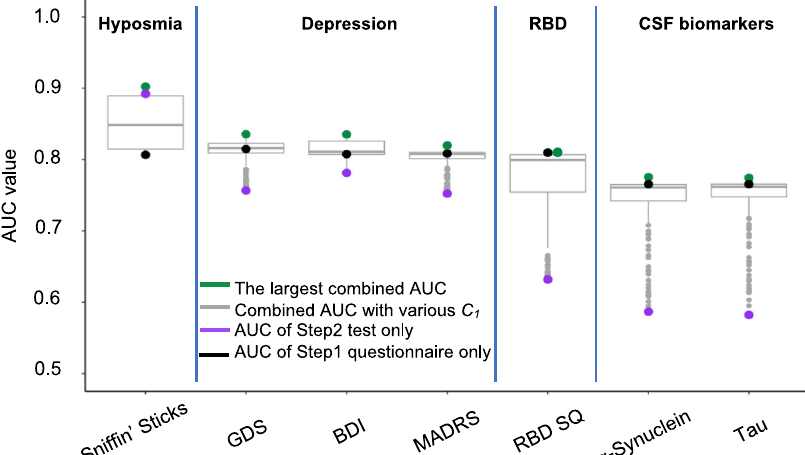
Fig. 7 Comparison of outcomes for a screening-adapted version of the PREDIGT Score (Model 2) to separate Parkinson ’ s patients from healthy controls in DeNoPa. Box plots illustrate the degree of classi fi cation, as depicted by AUC values for Step 1 (PREDIGT Questionnaire score only) and Step 2 (score for one of seven objective test results) and their combination, as color-coded in the inset). The box represents the median and the two middle quartiles (25 – 75%). Note, for RBD SQ, the largest combined AUC value was equal to the corresponding AUC of Step 1. Therefore, we placed extra green dots on top of the corresponding boxplot. Because of missing data, especially missing CSF α - synuclein or tau levels, sample sizes in these tests were not identical. Therefore, AUC values of Step 1 (in black) were not identical for the seven tests. AUC area under the ROC curve, GDS Geriatric Depression Scale, BDI Beck ’ s Depression Inventory, MADRS Montgomery-Asberg Depression Scale, RBD REM sleep behavior disorder Score Sheet, CSF cerebrospinal fl uid